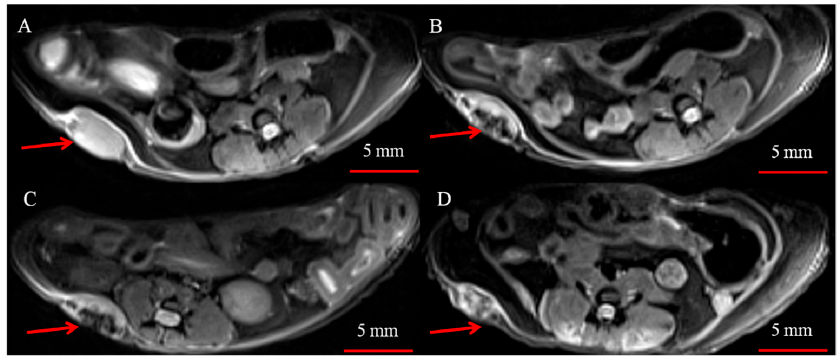
Figure 2 . Representative T2 weighted images of subcutaneous CT26 tumors (red arrows) before ( A ) and 1 h ( B ), 4 h ( C ) and 24 h ( D ) after i.v. injection of MNP-HSA@PS.